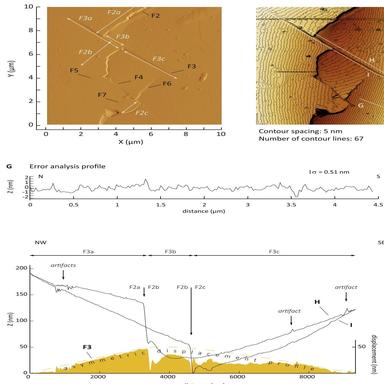
Topographic profiles of the surface of sample WS1.2. Upper left: Shaded relief AFM image with location of Profile A; upper right: unshaded nDTM with superimposed contours every 5 nm. Profile A shows the corrected topographic measurement of the surface of the sample in an area devoid of structural features used to estimate the error on topographic flatness, which results from polishing artifacts and AFM noise. Profiles B to C are taken at the top and bottom of a cross fracture. The orange surface is fracture